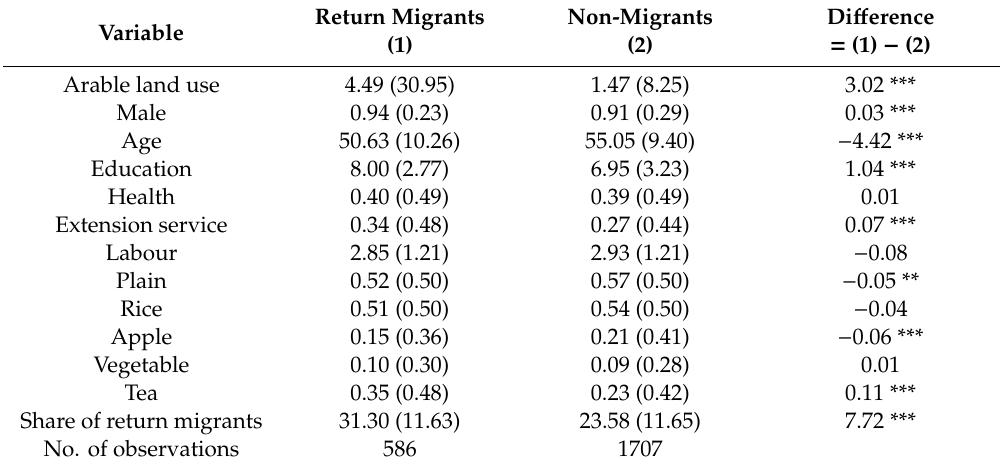
Table 3. Mean di ff erences of key variables between return migrants and non-migrants.